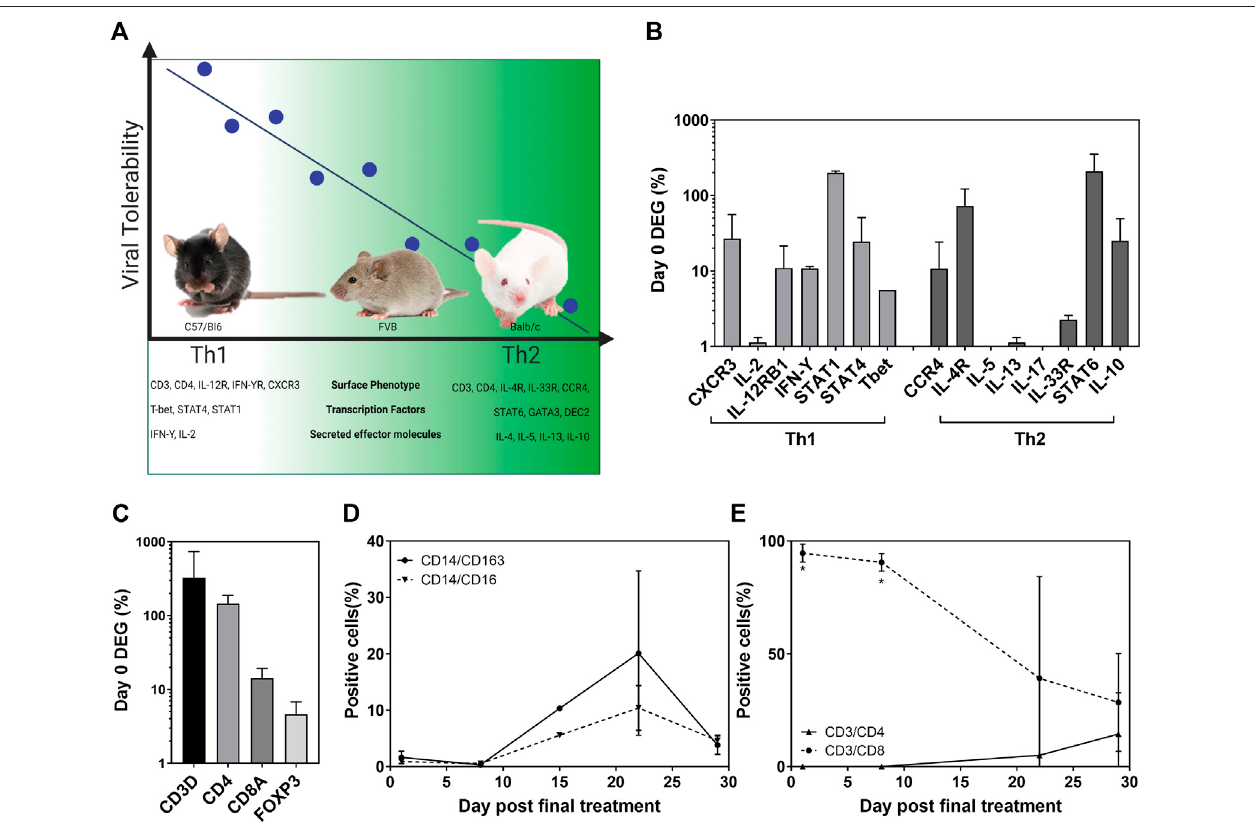
FIGURE 4 | Viral tolerability correlates with host Th bias in both mice and humans. Murine tolerability of HSV1716 correlated with T helper cell polarization associated with prototypical strains of inbred mice [ (A) , created using BioRender]. Pleural effusion samples taken from MPM patients ( n = 2), having received four doses of HSV1716, revealed a Th1-dominant cytokine pattern (B) and T-cell activation (C) , following the analysis of differentially expressed genes (DEG) by NanoString. Flow cytometry of cell populations demonstrated an overall balanced immune system in the weeks following treatment (D) with a signi fi cant CD8 + T-cell – mediated response which declined over time (E) . Data are shown as mean ± SD. Statistical signi fi cance was determined by Students t-test where p = p <